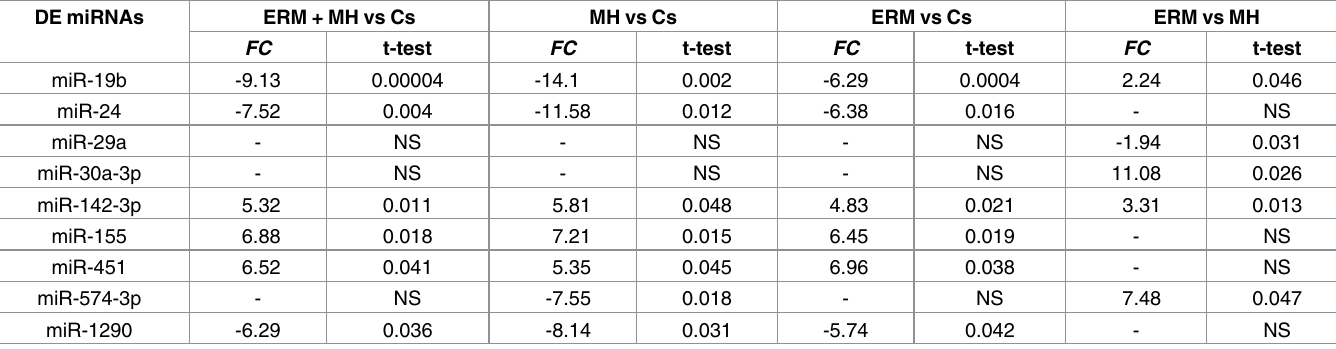
TaqMan 1 assays in the VH of all the patients and controls (Table 2) (Fig 1) (S1 File). Table 2. Differentially expressedvitreal